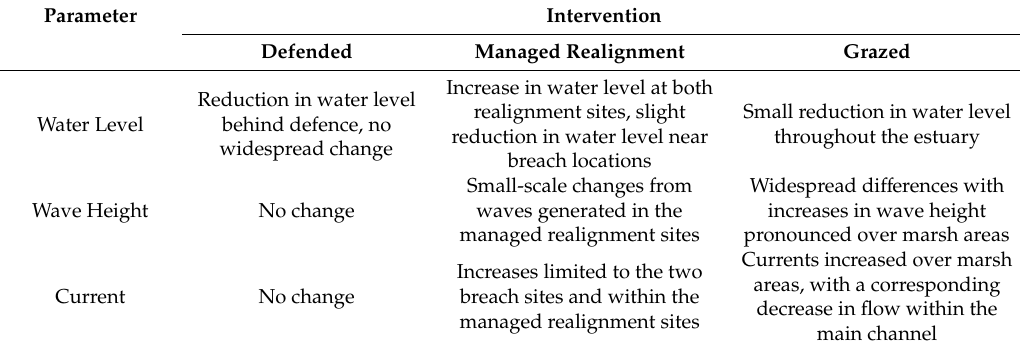
Table 5. A summary of the impacts of coastal management intervention options on waves and hydrodynamics of the Taf